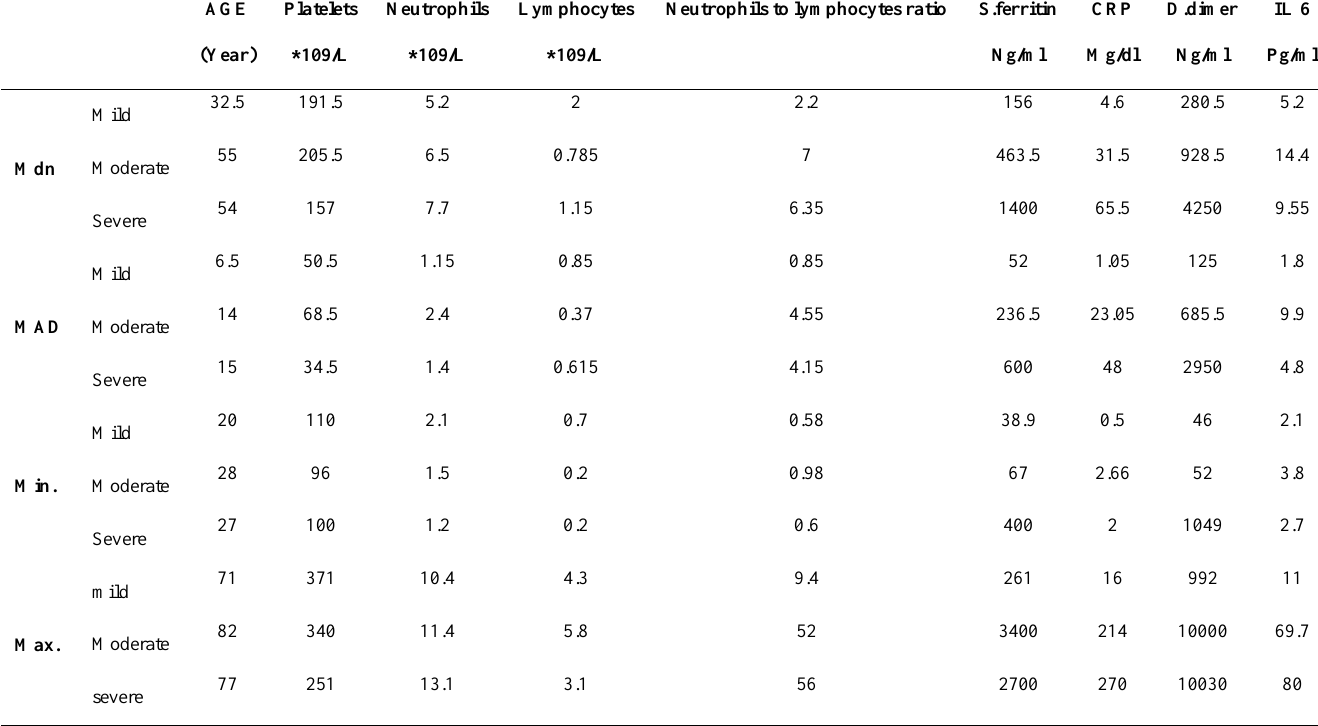
Table 1: Description of hematological and inflammatory parameters of 60 patients according to